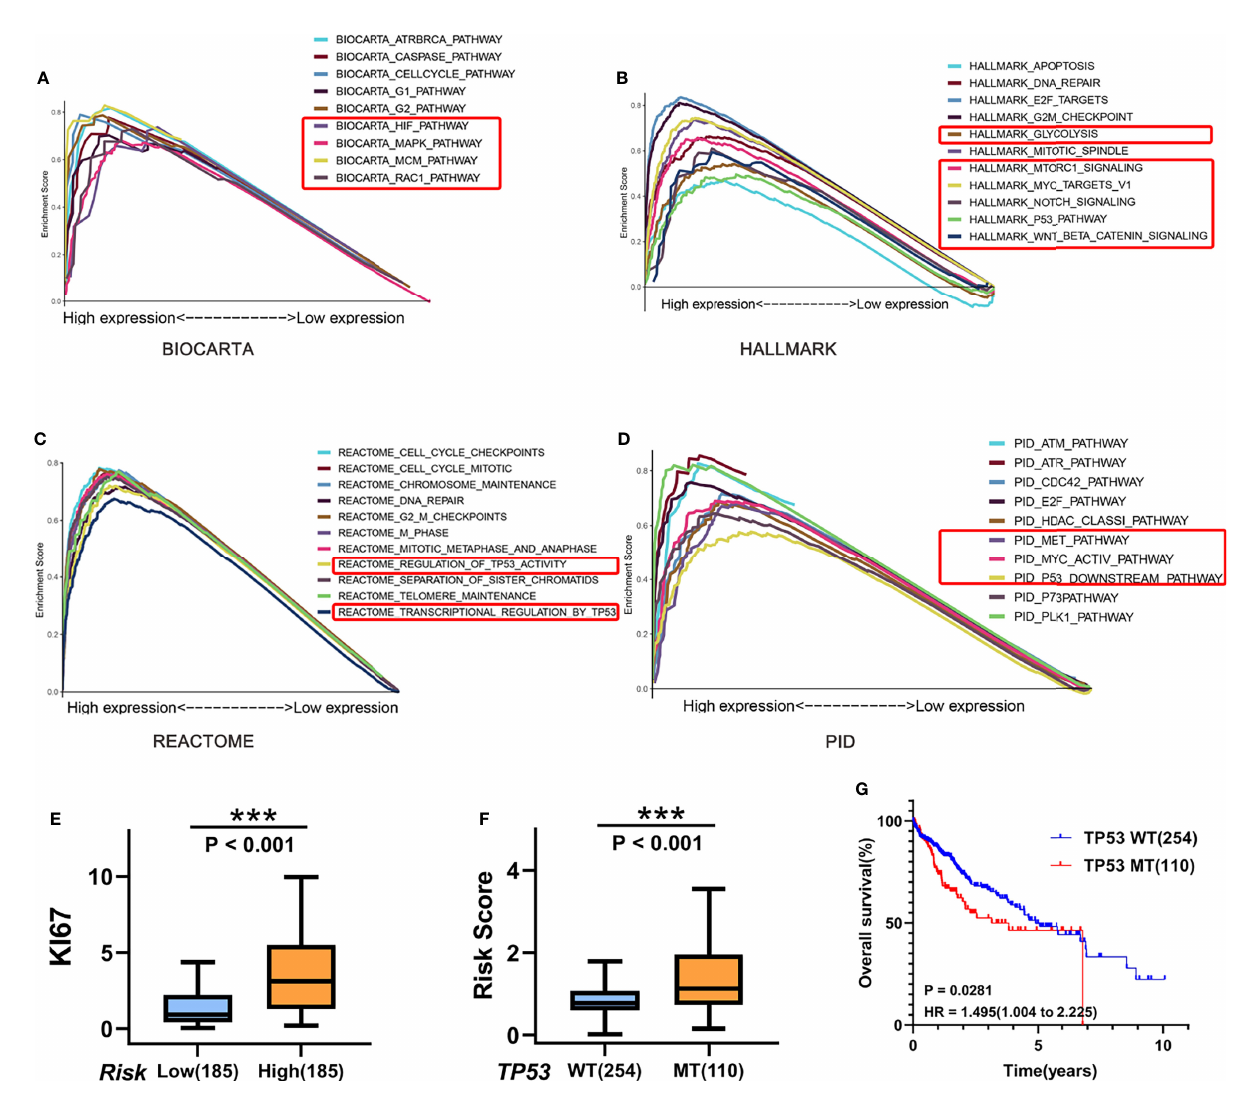
FIGURE 8 | Biological and functional analysis. (A – D) Pathway analysis in the high-risk group using (A) BIOCARTA, (B) Hallmark, (C) REACTOME, and (D) PID gene sets by GSEA. (E) Boxplots of KI67 gene expression in the high-risk (n = 254)/low-risk (n = 110) group in TCGA cohort. (F) Boxplots show the differences of the risk score between TP53-wild type (n = 254) and TP53-mutant (n = 110) for HCC patients in TCGA cohort. (G) Kaplan – Meier curves for correlation of OS with TP53 mutation status for HCC in TCGA cohort. ***P <